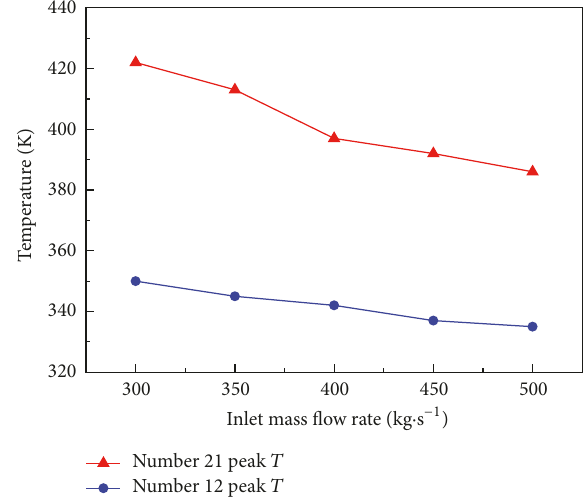
Figure 16: Variations of the peak temperatures in number 12 and number 21 fuel assemblies for various inlet conditions.